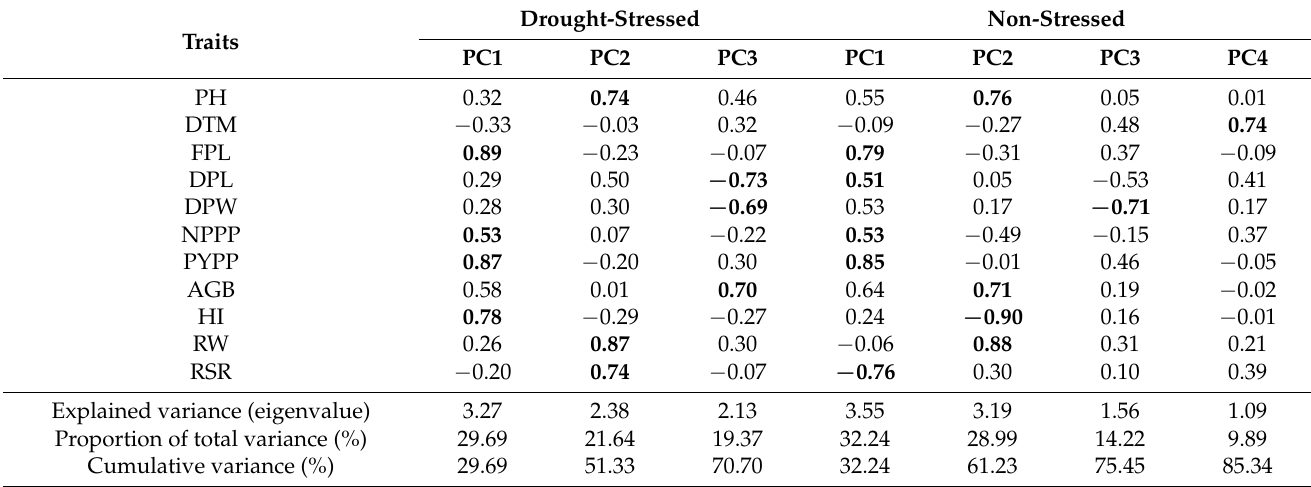
Table 7. Principal component loading scores explained and cumulative variances of phenotypic traits among 26 okra accessions under drought-stressed and non-stressed conditions.